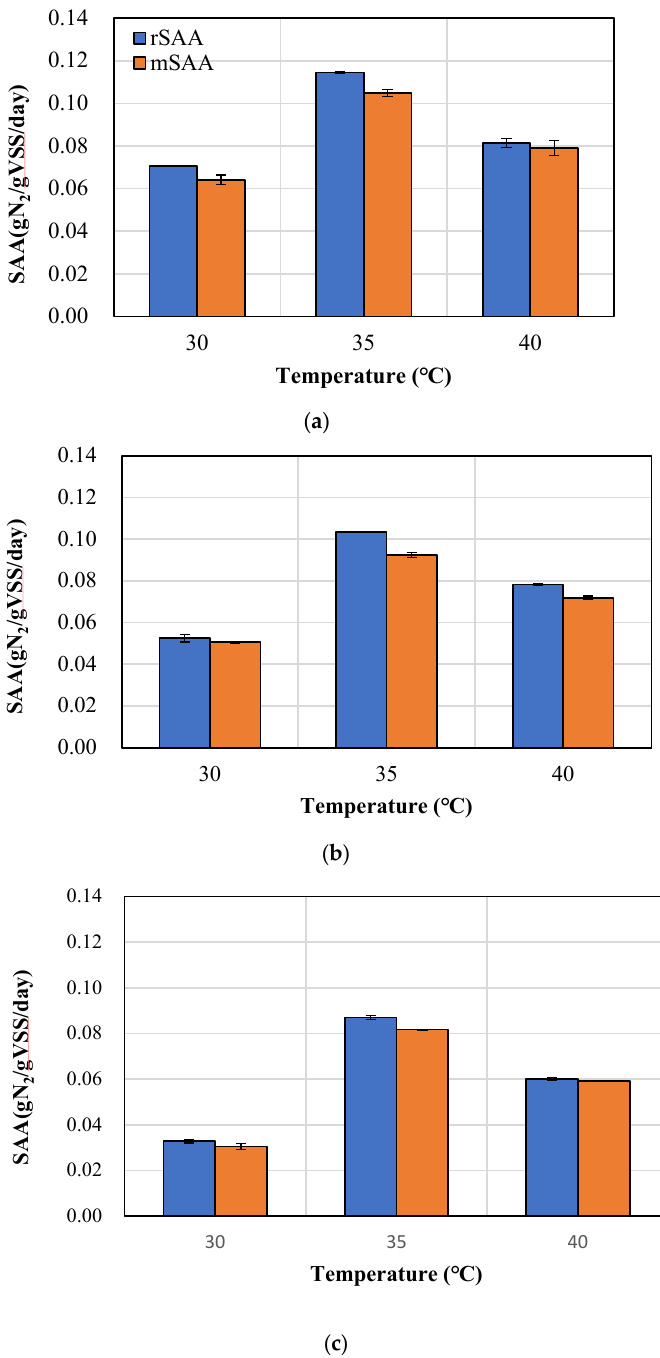
Figure 3. The rSAA and mSAA changes according to the temperature by granular size. ( a ) Granule size <1 mm, ( b ) granule size 1~2 mm, and ( c ) granule size >2 mm.